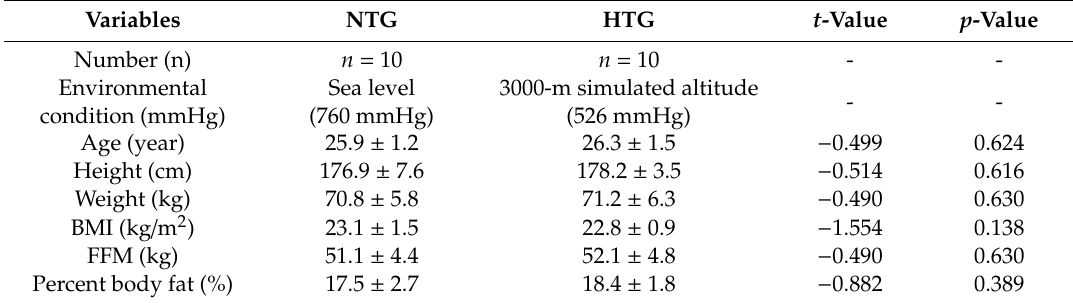
Table 1. Characteristics of the